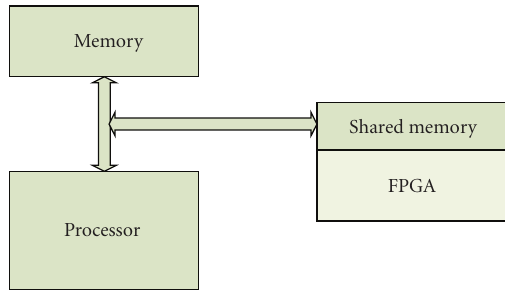
Figure 5: Two separated memories architectural model.